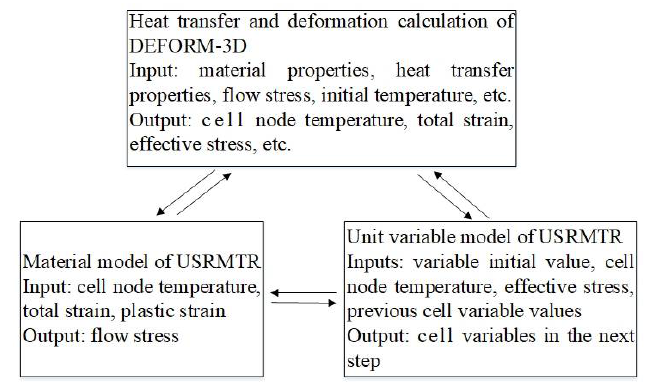
Figure 5. Relationship of thermal-force microstructure of DEFORM-3D.